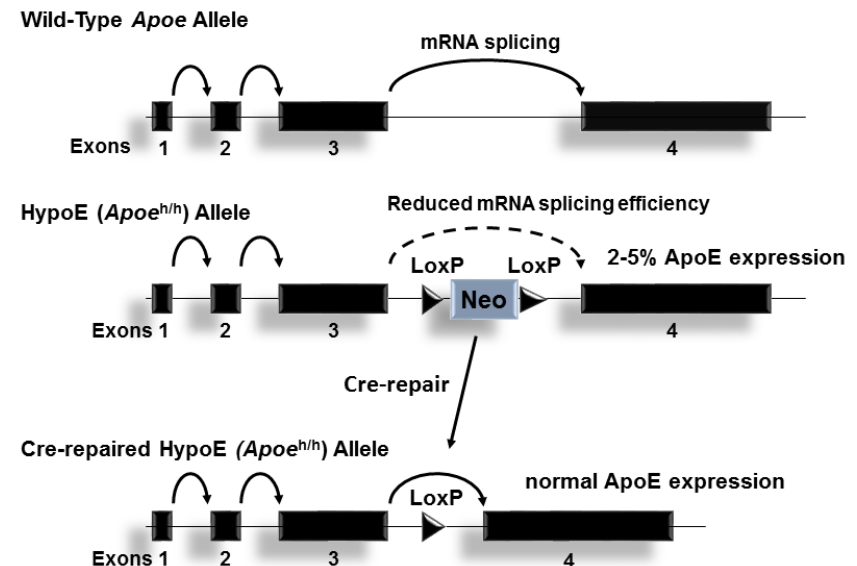
Figure 1. The Hypomorphic Apoe h/h allele: The wildtype mouse Apoe allele is composed of 4 exons on chromosome 7. A neomycin resistance cassette flanked by loxP sites introduced into intron 3 reduces ApoE expression levels of the gene in all tissues, presumably by interrupting RNA splicing. Cre-mediated removal of neo cassette restores Apoe expression to physiological levels.